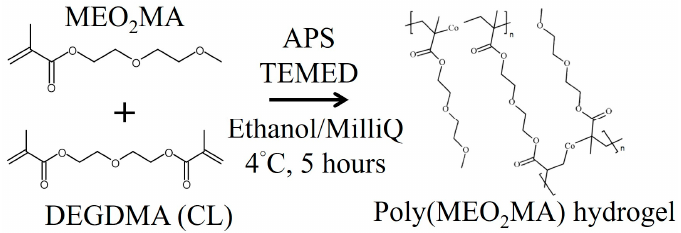
Figure 2. The synthesis of the poly(2-(2-methoxyethoxy)ethyl methacrylate) hydrogel (poly(MEO 2 MA) hydrogel) by redox polymerisation. DEGDMA (cross-linker; CL): di(ethylene glycol)